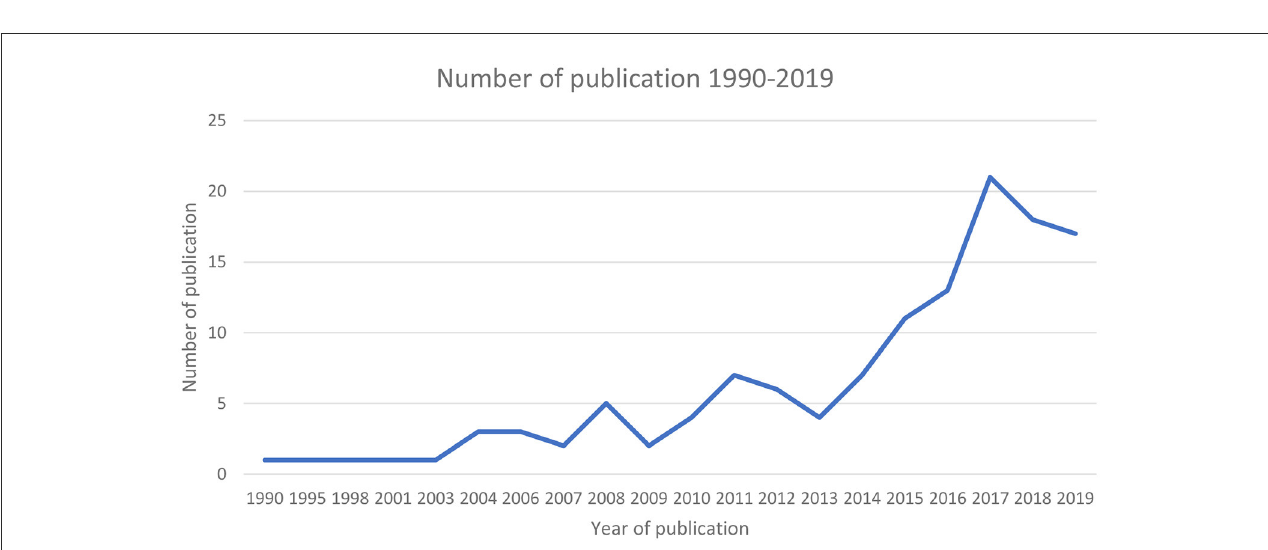
FIGURE3 Number of retained publications on FBD in Ethiopia between 1990 and 2019. The solid line shows actual number of articles published in a particular year.